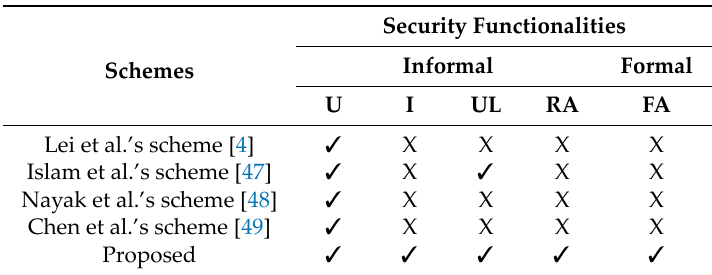
Figure 7. Communication cost (in bits).